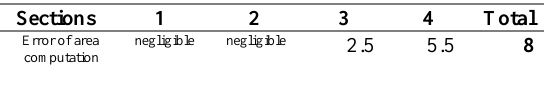
Fig. 5. Coastline classification according to the corresponding shoreline topography. Table 2. The estimated error for each of the classified coastline